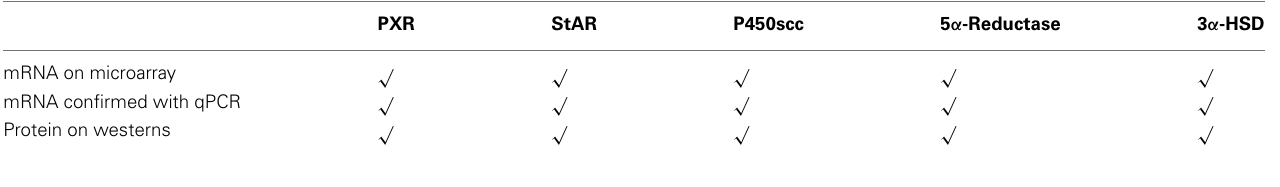
Table 1 | Expression confirmed in midbrainVTA of proestrous rats for pregnane xenobiotic receptor (PXR) and biosynthesis and metabolism proteins/enzymes required for 3 α ,5 α -THP formation [steroid acute regulatory protein (StAR), P450 side chain cleavage enzyme (P450scc), 5 α -reductase, and 3 α -hydroxysteroid dehydrogenase (3 α